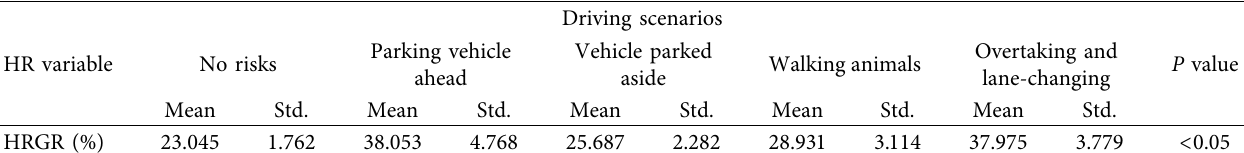
Figure 6: Fixation transition probability heat map at random risk point. (a) No risks. (b) PVA. (c) VPA. (d) WA. (e) O&L. Table 4: Descriptive statistics (mean and standard deviations) for HRGR measure in different risk scenarios.